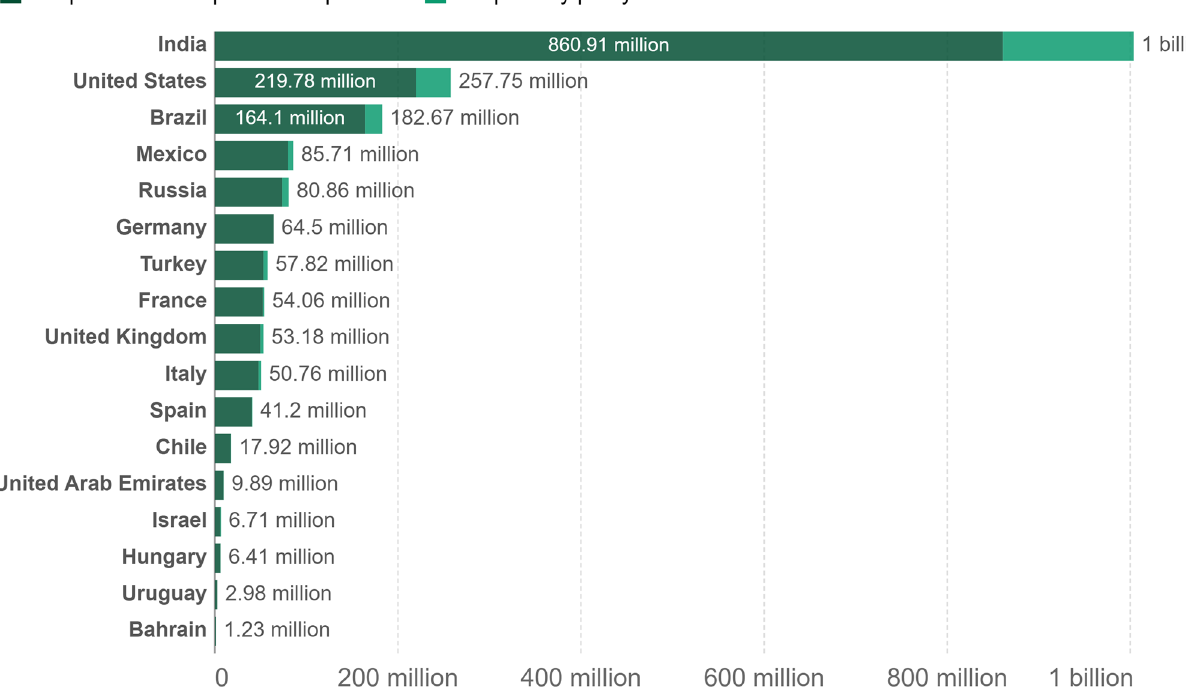
maximize comparability between countries. These data are only avail- able for countries that reported the breakdown of doses administered by the first and second doses in absolute numbers [17]